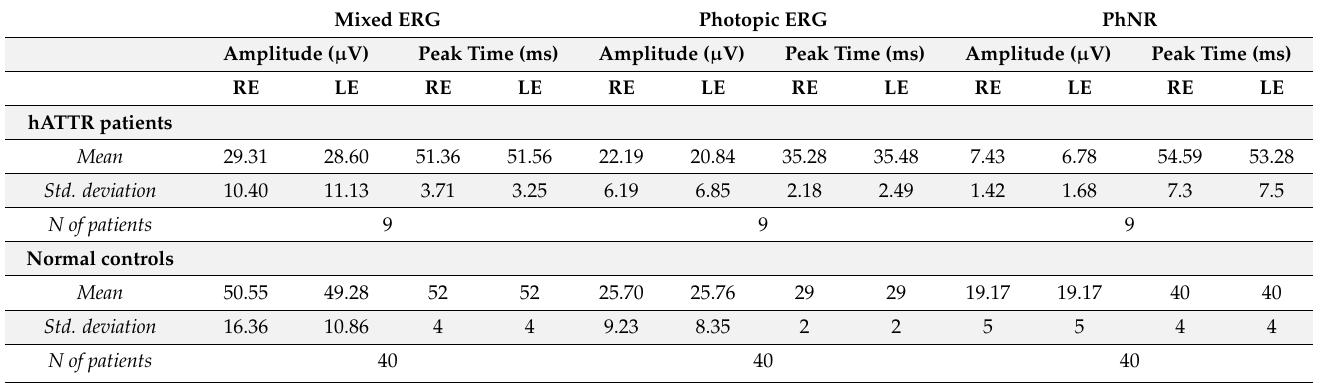
ERG: electroretinogram; LE: left eye; RE: right